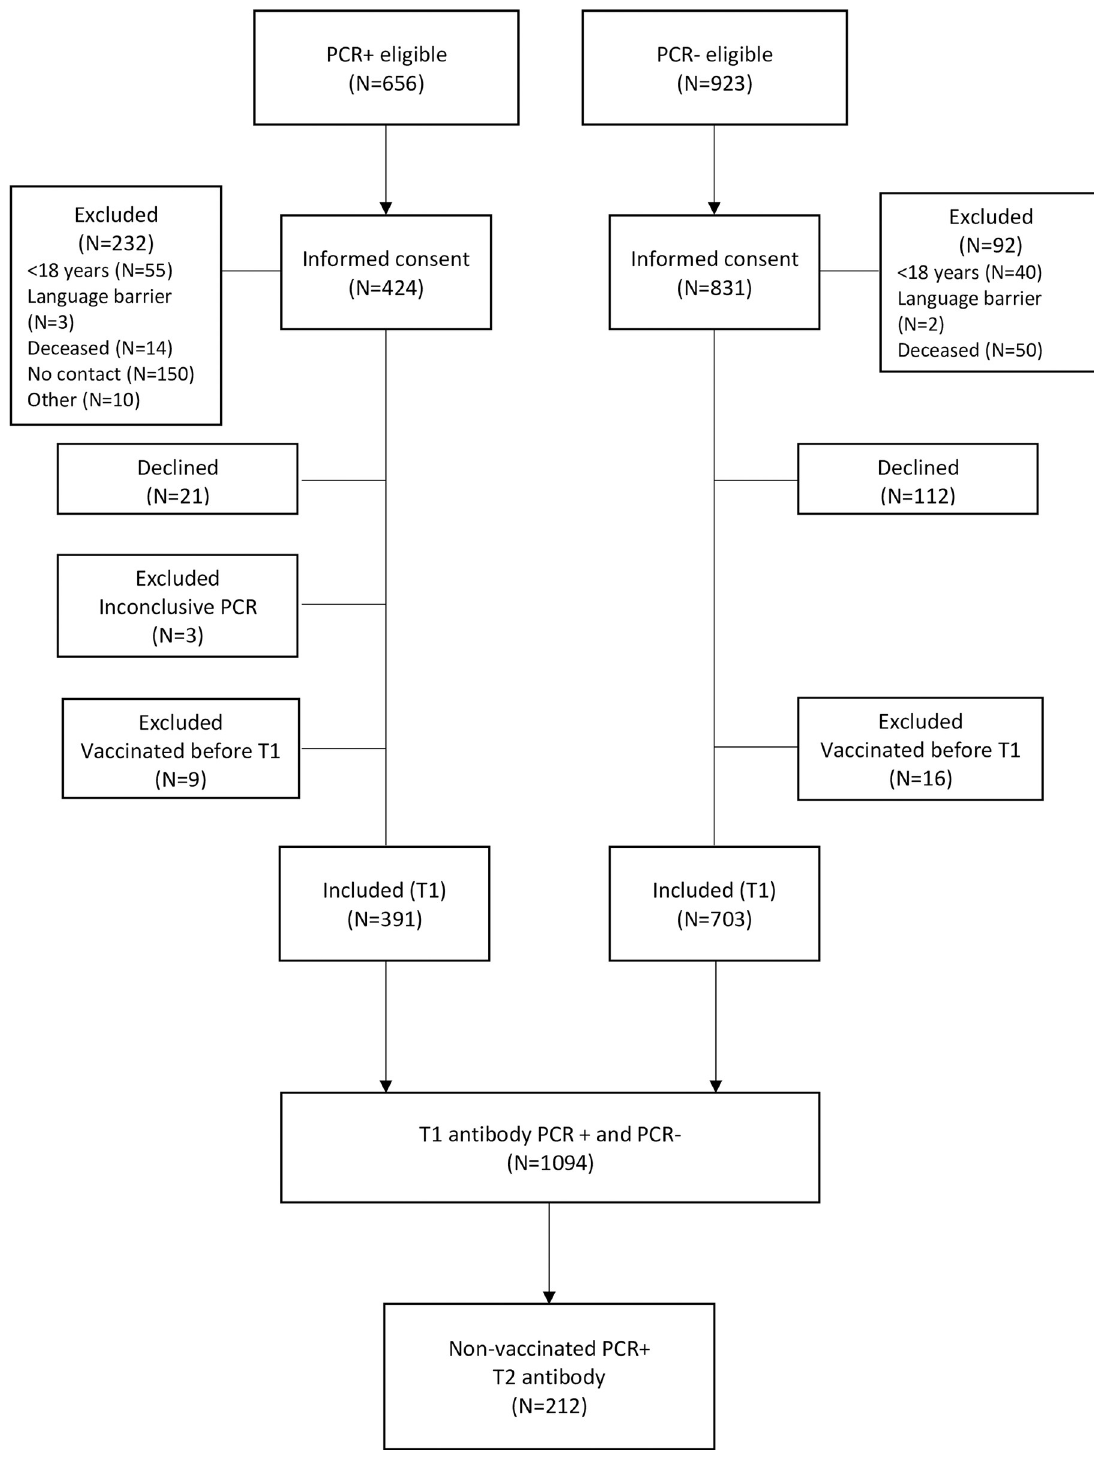
Fig 1. Flow chart for the study.